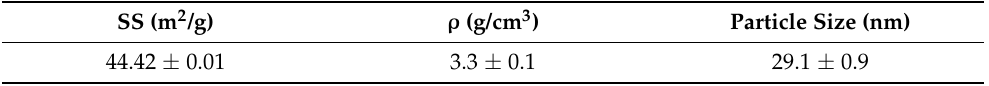
Table 1. Morphological characterization of the TiN